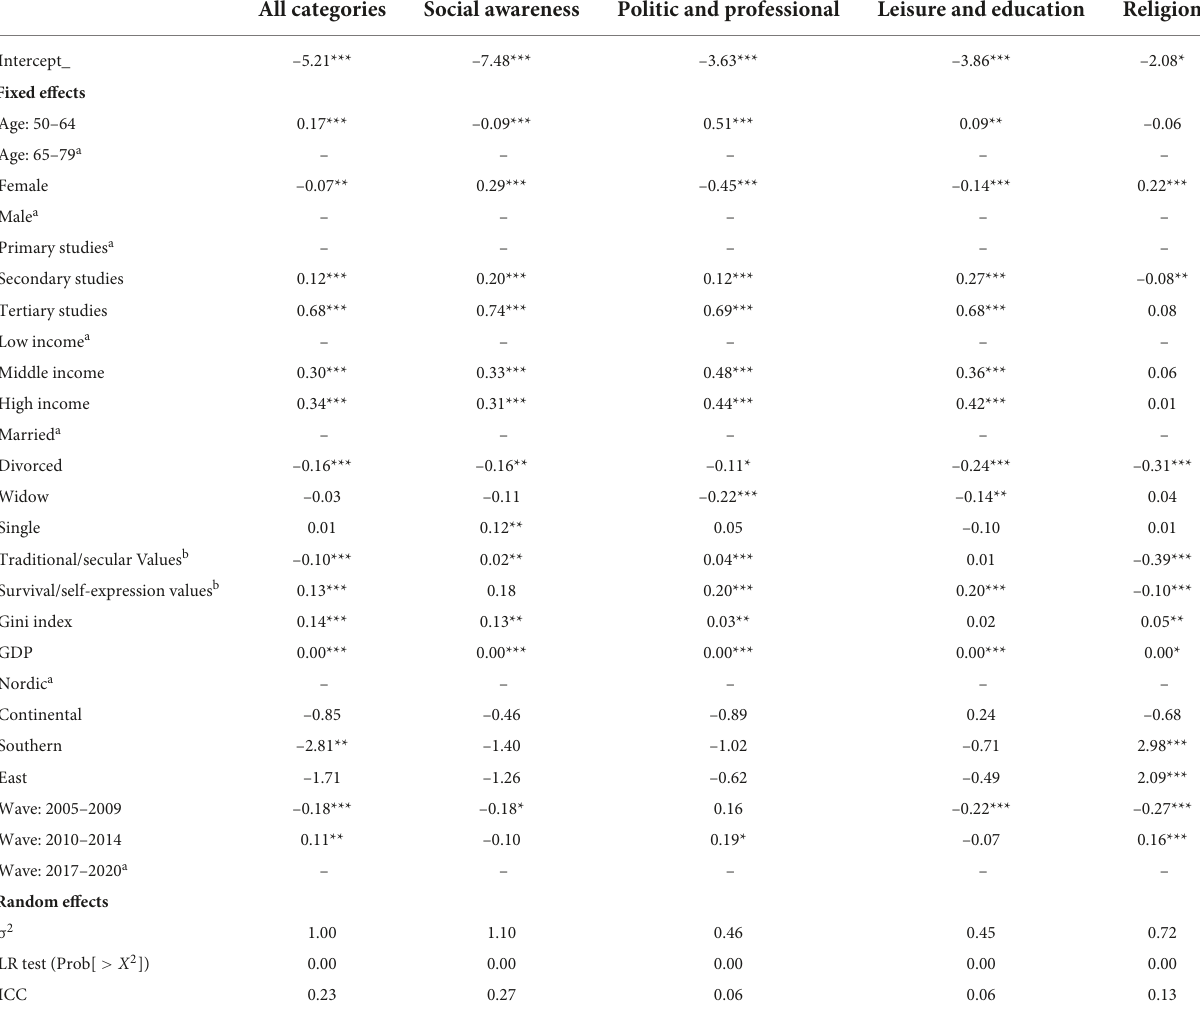
TABLE 3 Estimations of individual-level and national-level variables on volunteering: Model